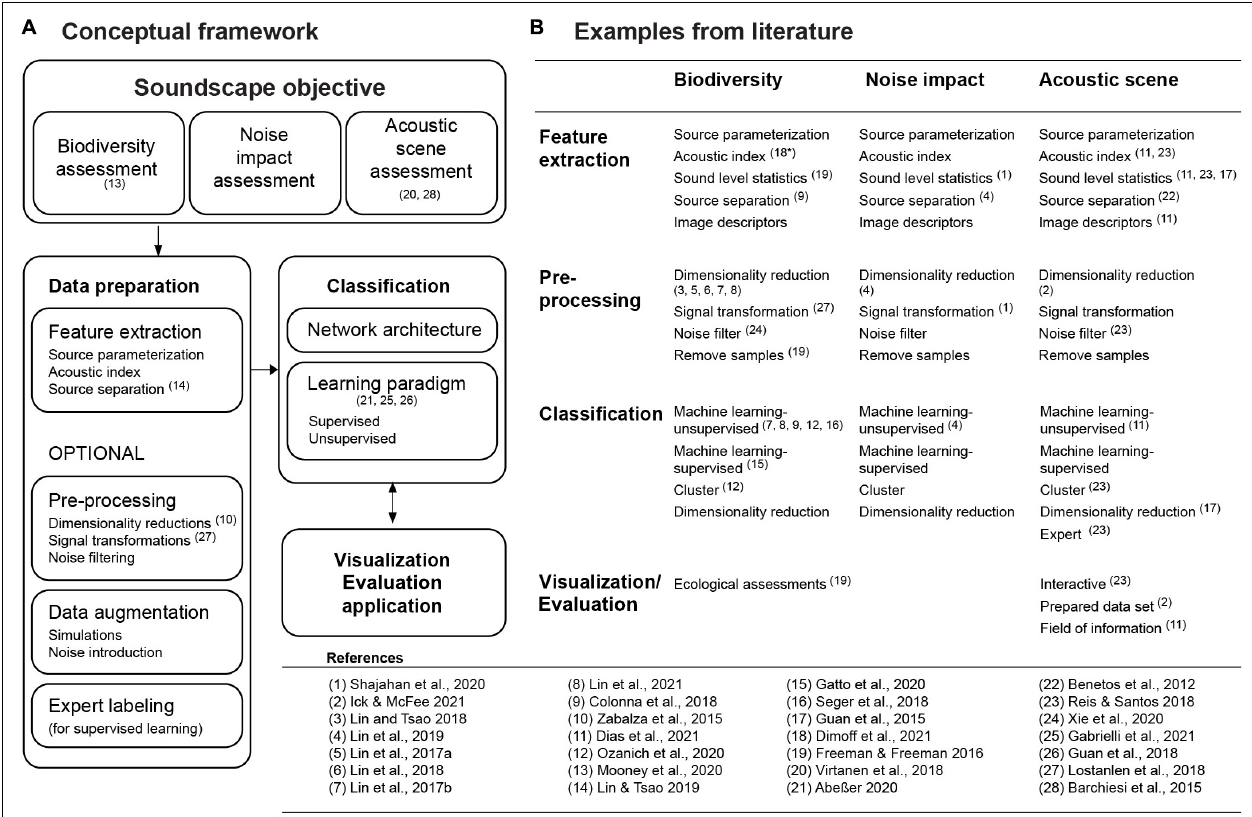
FIGURE 11 | Conceptual framework for approaching soundscape analysis (A) and a summary of methodological approaches from the literature (B) . The literature referenced simply serve as examples, and not an exhaustive or systematic search of the literature. References cited in the table: (Barchiesi et al., 2015;